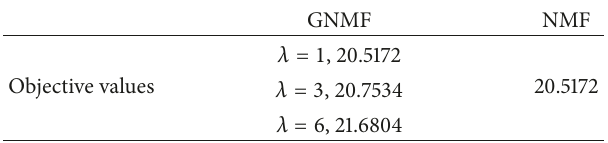
Table 5: Comparisons between GSNMF using different 𝜆 and NMF.